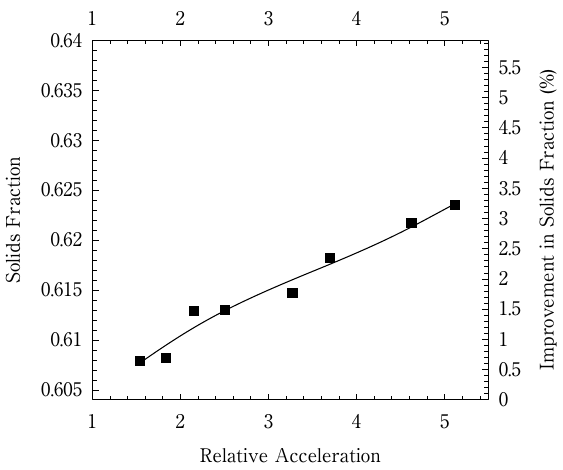
Fig. 2 Solids fraction versus relative acceleration at a/d = 0.04. The solid line is a best fit curve to show the trend.